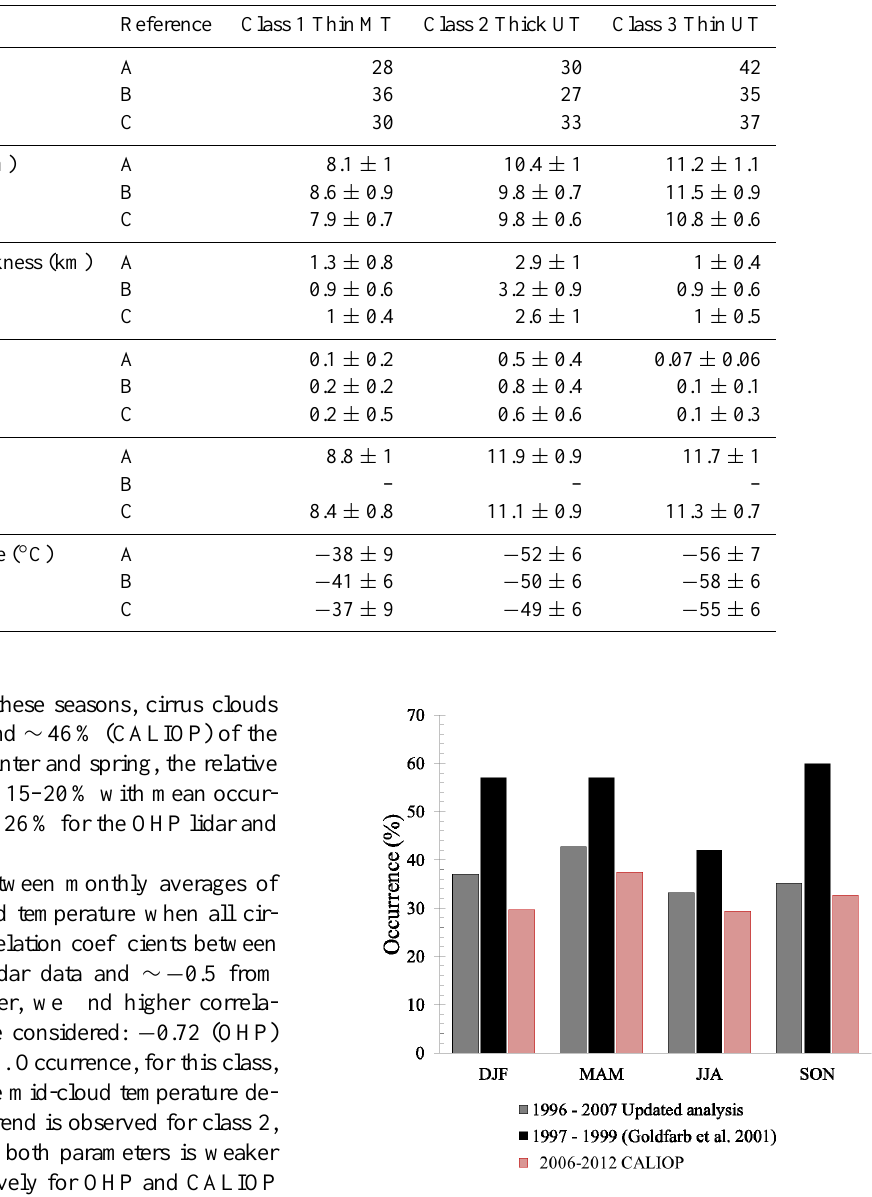
Fig. 6. Seasonal cirrus clouds occurrence over the OHP site from Figure 6. Seasonal cirrus clouds occurrence over the OHP site from our analysis of OHP lidar 2 our analysis of OHP lidar data (gray), from Goldfarb et al. (2001) data (gray), from Goldfarb et al. (2001) (black) and from CALIOP data (red). 3 (black) and from CALIOP data